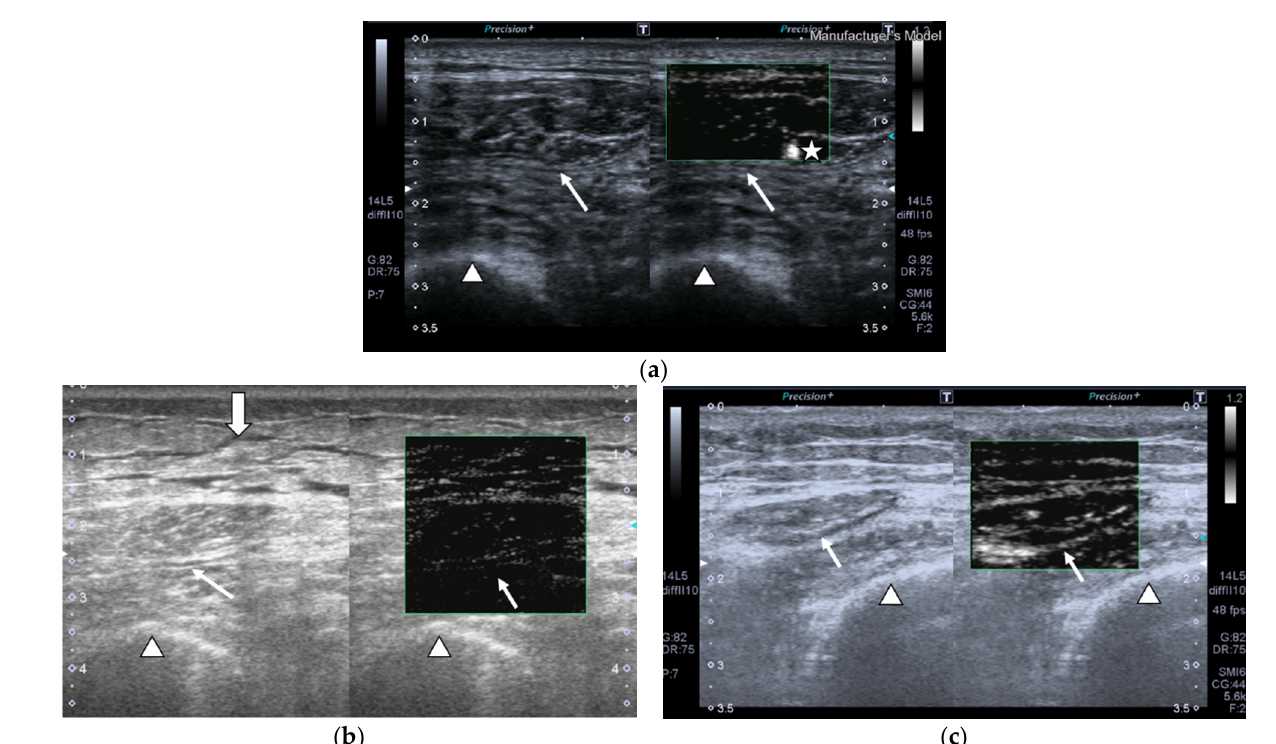
Figure 2. Transversal QRF muscle US scan and the superb microvascular imaging (SMI) built-in software that indicates microvascularization. ( a )Transversal QRF muscle (arrow) US scan, femur (arrowhead). SMI image shows dot-like vessels and a penetrating vessel (star) for a matched healthy control (60 years old). ( b ) Transversal QRF muscle (arrow) US scan, femur (arrowhead); subcutaneous edema with intramuscular and interfacial fluid (thick arrow). SMI image shows dot-like vessels for a patient with multiorgan failure (58 years old). ( c ) Transversal QRF muscle (arrow) US scan, femur (arrowhead). SMI image shows minimal linear vessels for another patient with multiorgan failure (51 years old).